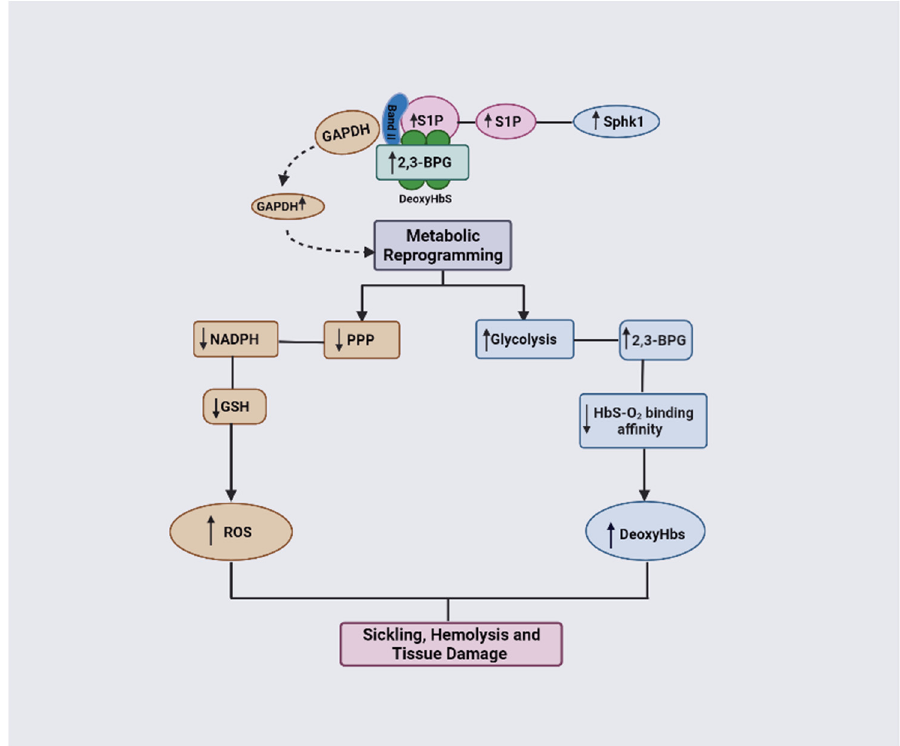
Figure 8. DeoxyHbS anchoring to membrane results in the release of GAPDH. Increased cytosolic GAPDH accelerates glycolysis and 2,3-BPG production while decreasing PPP and antioxidant pro- duction. Increased 2,3-BPG leads to increased formation of the polymer-forming deoxyHbS while a decreased antioxidant level causes more oxidative stress (ROS).